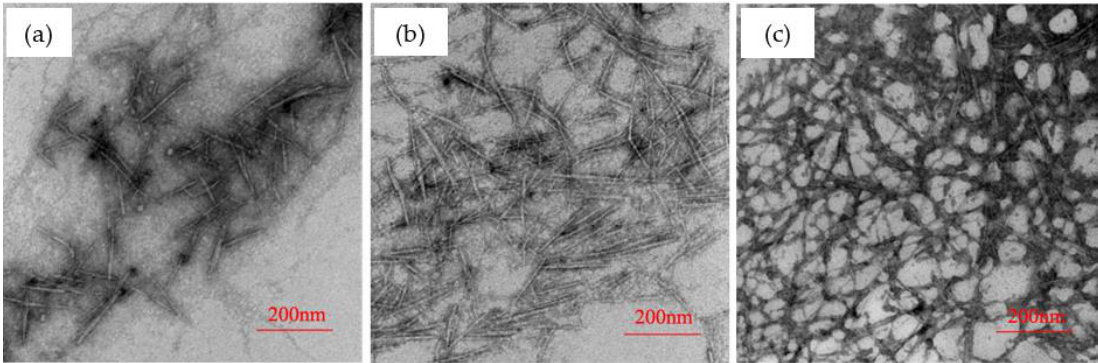
Figure 1. The TEM images of CNF/CdS nanocomposites with different –COOH/CdS ratios; ( a ) –COOH/Cd 2+ = 0.5; ( b ) –COOH/Cd 2+ = 1.0; and ( c ) –COOH/Cd 2+ = 2.0 (the feeding time of Na 2 S was 20 min, and the ultrasonic maturing time was 60 min).